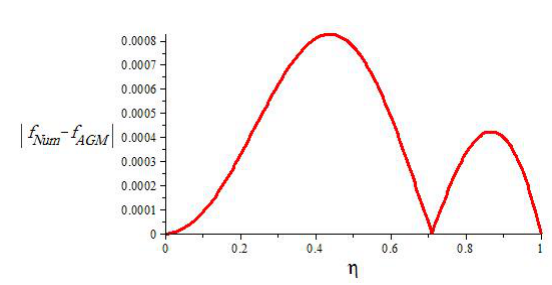
Figure 6. Theabsolutedifferencebetweentheobtainedsolutionsby AGM and Numeric Method for f ( η ) .